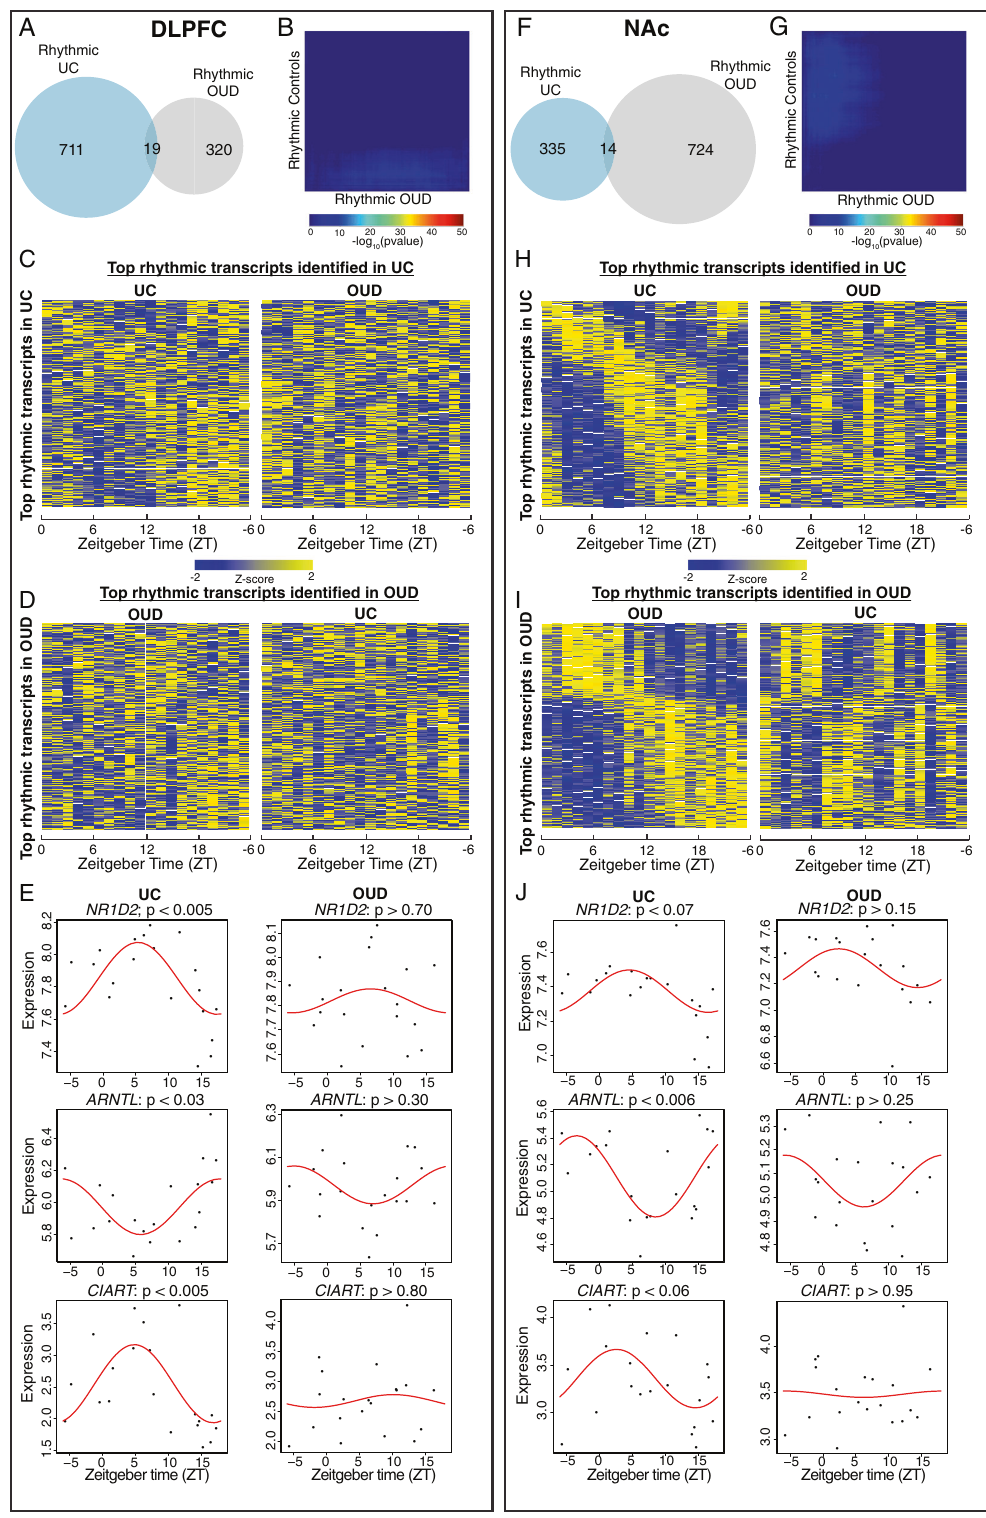
comparison subjects, with TMEM119, ADPRH , and HELLS as the top transcripts (Fig. 3B ; Table S8). The top pathways associated with transcripts that were more rhythmic in OUD subjects in the DLPFC included inositol biosynthesis and metabolism, along